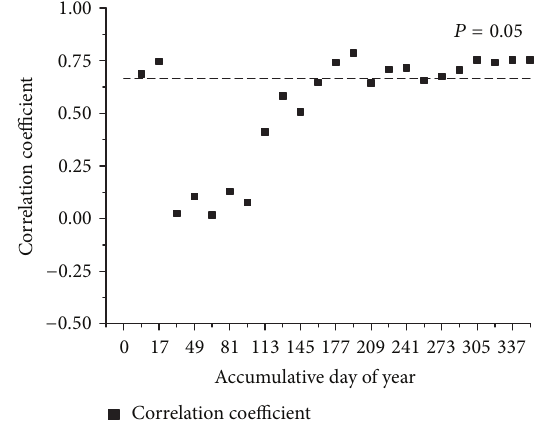
Figure 4: Correlation coefficients between mean annual NDVI and accumulative precipitation for each 16-day period in a year for the shrubland within Gurbantunggut